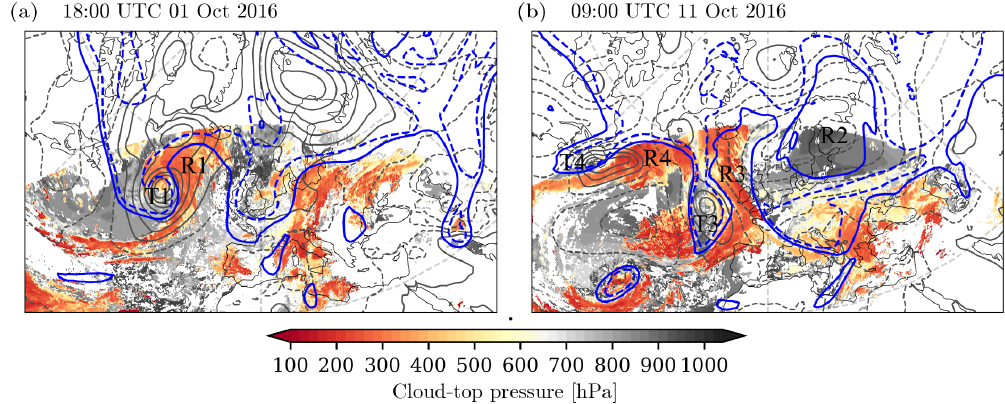
Figure 1. Synoptic situation over the North Atlantic at (a) 18:00UTC 1 October 2016 and (b) 09:00UTC 11 October 2016. SLP (gray contours, every 10hPa, solid to dashed contours at 1015hPa) and upper-level PV (blue contours, 2 (solid) and 3 (dashed) pvu) from the IFS CNTRL run after (a) 42h lead time for Thor onset and (b) 36h lead time for Thor maintenance. Labels “T1–T4” mark troughs (cyclones) and “R1–R4” mark ridges (anticyclones) and are described in the text. Cloud-top heights (hPa, shading) from satellite imagery are based on EUMETSAT MSG-SEVIRI data (EUMETSAT, 2017).